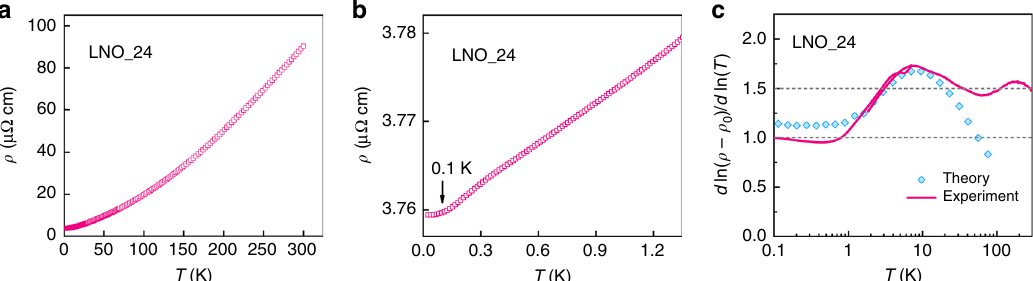
Fig. 1 Temperature dependence of resistivity and evolution of the resistivity exponent. a Resistivity of LNO measured as a function of temperature from 300 K to 2 K. b Linear-in-temperature resistivity observed at temperatures below about 1.1 K. c Temperature dependence of the resistivity exponent α (solid line) from 300 K to 100 mK. The two horizontal dashed lines indicate exponent values of 1 and 1.5, respectively. Symbols show theoretical predictions of the resistivity exponent α for a clean sample ( k F l ~ 1000) at